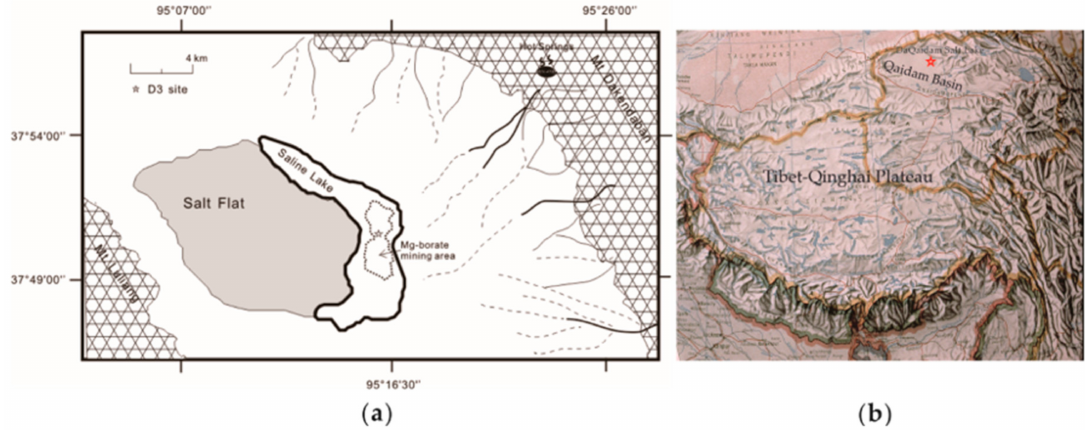
Figure 1. DaQaidam Salt Lake ( a ) is a closed-basin lake, located in the northern Qaidam Basin of the Tibet-Qinghai Plateau ( b ). It includes both perennial saline lake and salt flat with a total area of ~235 km 2 . The boron deposit found in the subbottom evaporitic sequence is of Mg-borate type, distributed in the dotted area of the saline lake. The empty star indicates the location of the D3 section of the evaporitic